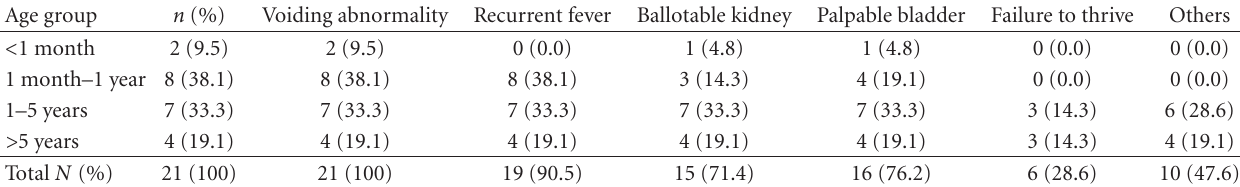
Table 1: Age distribution of patients and clinical features at